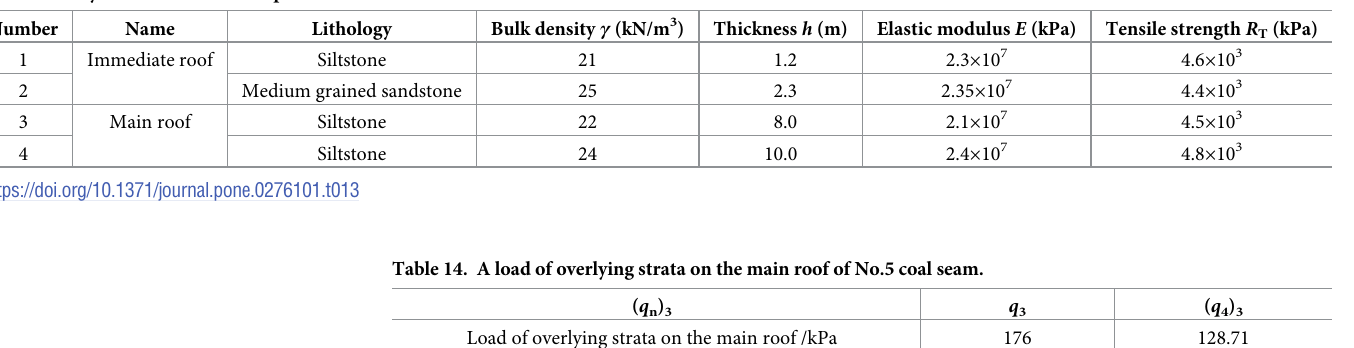
Table 13. Physical and mechanical parameters of overburden strata above No.5 coal seam..